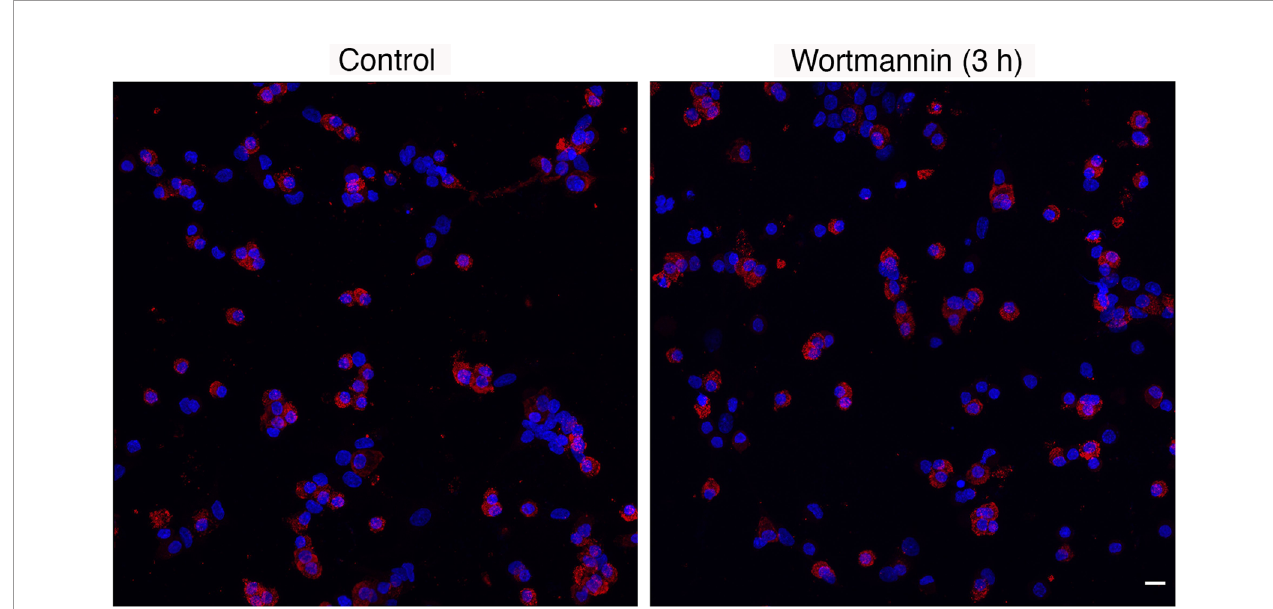
FIGURE 3 | Immuno fl uorescence analysis of prolactin protein expression in control and Wm (10 µM/3h)-treated pituitary cells. Red indicates prolactin-positive cells; blue indicates cell nuclei stained with DAPI. Scale bar applies to both images: 10 µM. The mean ± SEM values of the percentage of PRL-positive cells in controls was 33.7 ± 2.1 (n = 8) and in Wm-treated cultures was 32.1 ± 2.7 (n = 8).